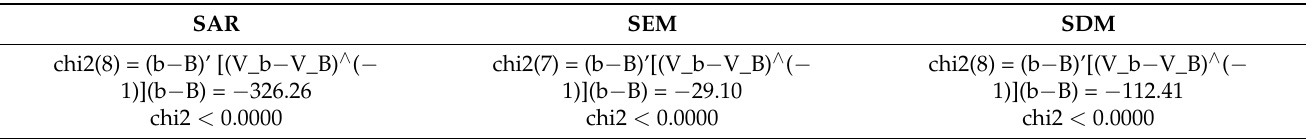
Table 4. Results of Hausman test.